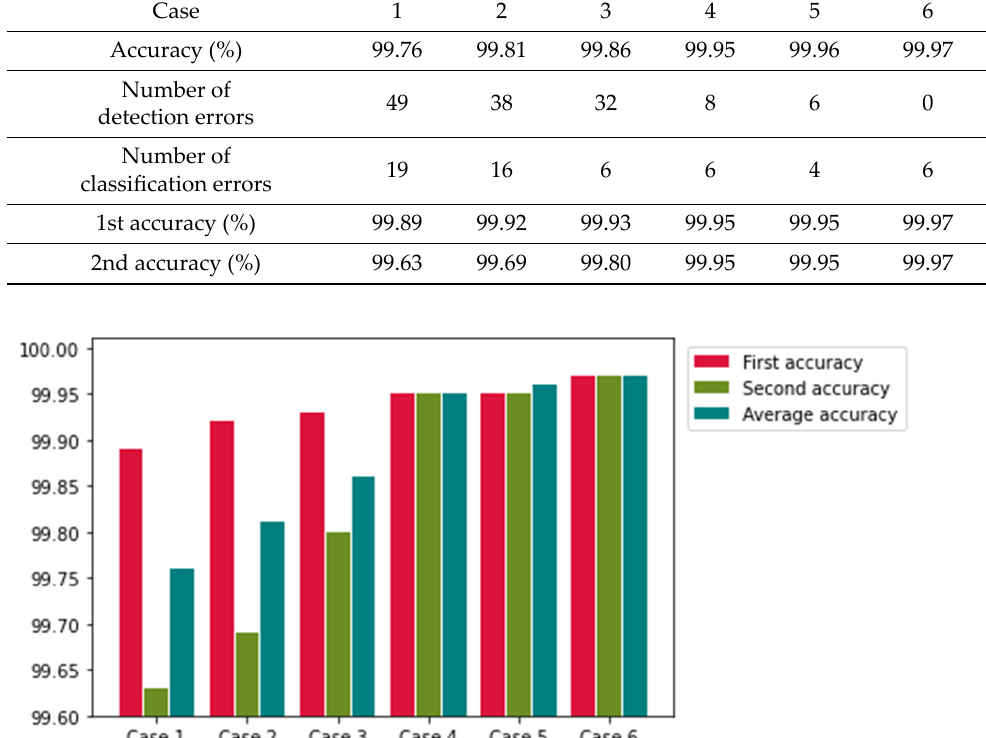
Figure 9. Graphical accuracy comparison for the result of Table 4.